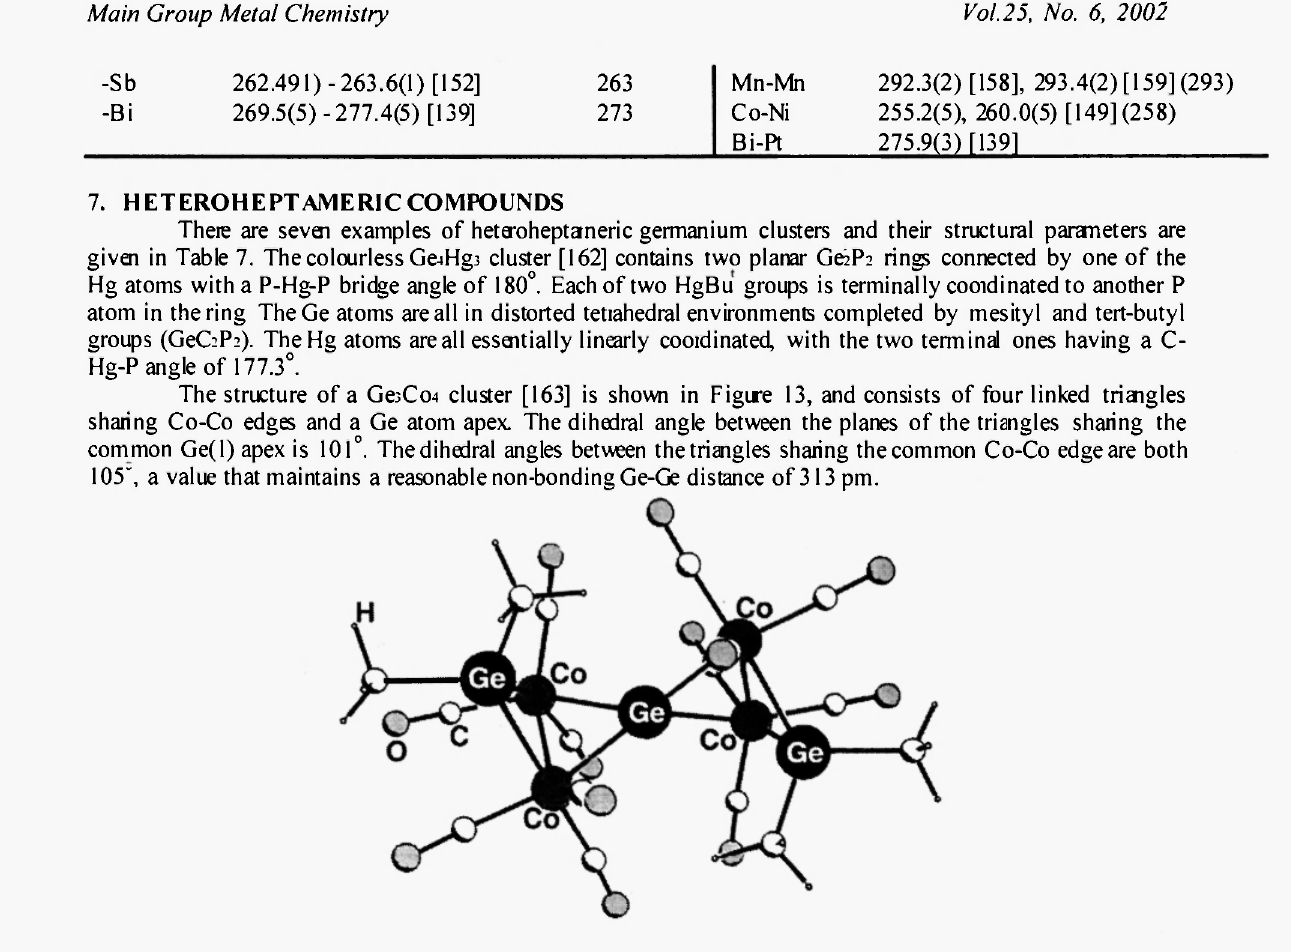
Fig. 13. Structure of ^4Ge{Co2^-GeMe)2(CO>}2|